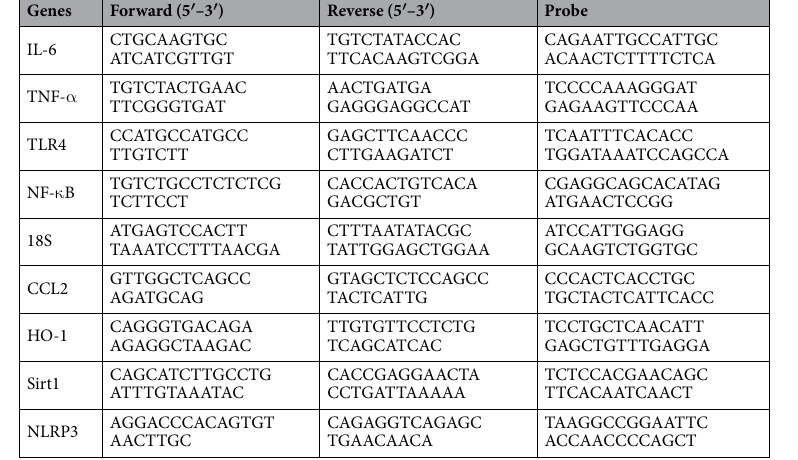
Table 1. Primer sequences and probes used in this